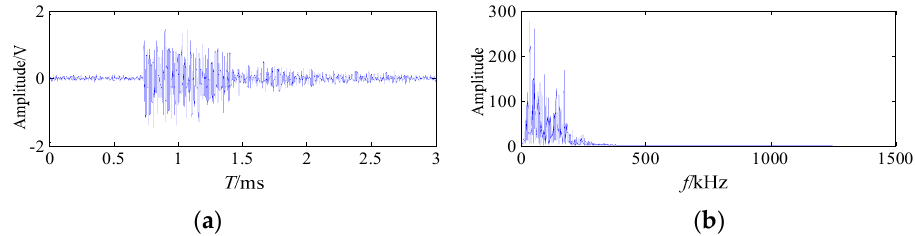
Figure 12. The waveform and spectrum of the welding crack AE signal ( a ) the waveform; ( b ) the frequency spectrum.